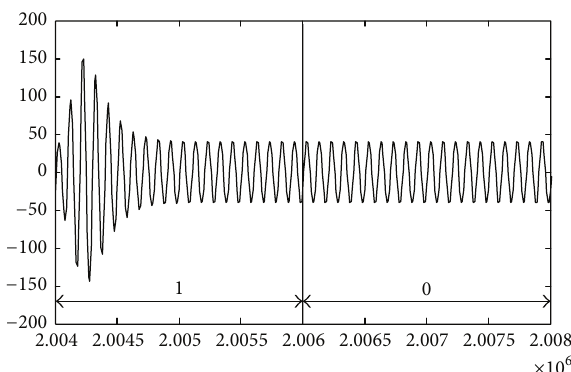
Figure 1: 3PPSK modulated waveforms.